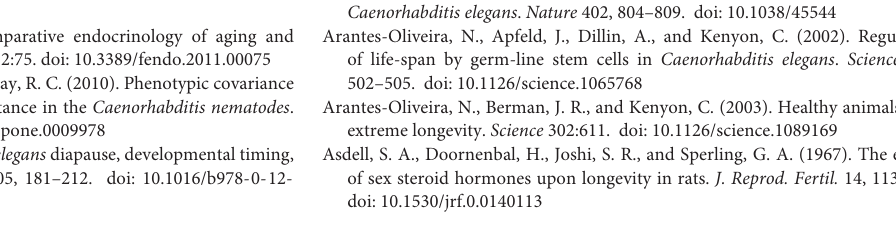
Figure 3A (right) was reprinted from Farrell (2002), Figure 3A (bottom left) from Maldonado et al. (2000), and Figure 3B (bottom) from Higashi et al. (2005), all with permission from Elsevier. Figure 7A image (lactation, photo by Dmytro Vietrov) reproduced with